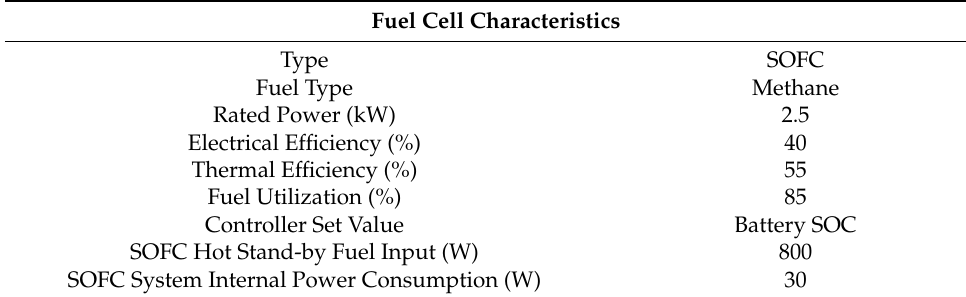
Table 5. The main characteristics of the modelled fuel cell system.